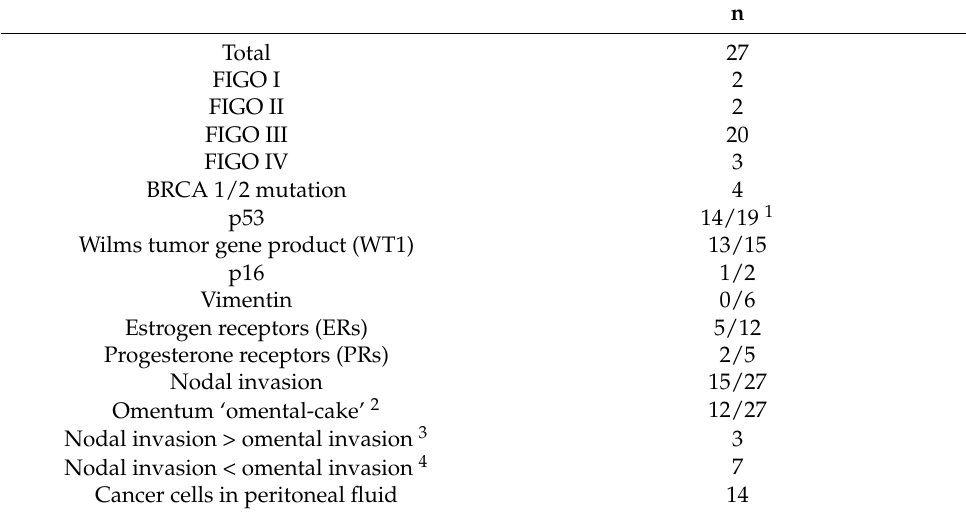
Table 2. Histopathological characteristics of study